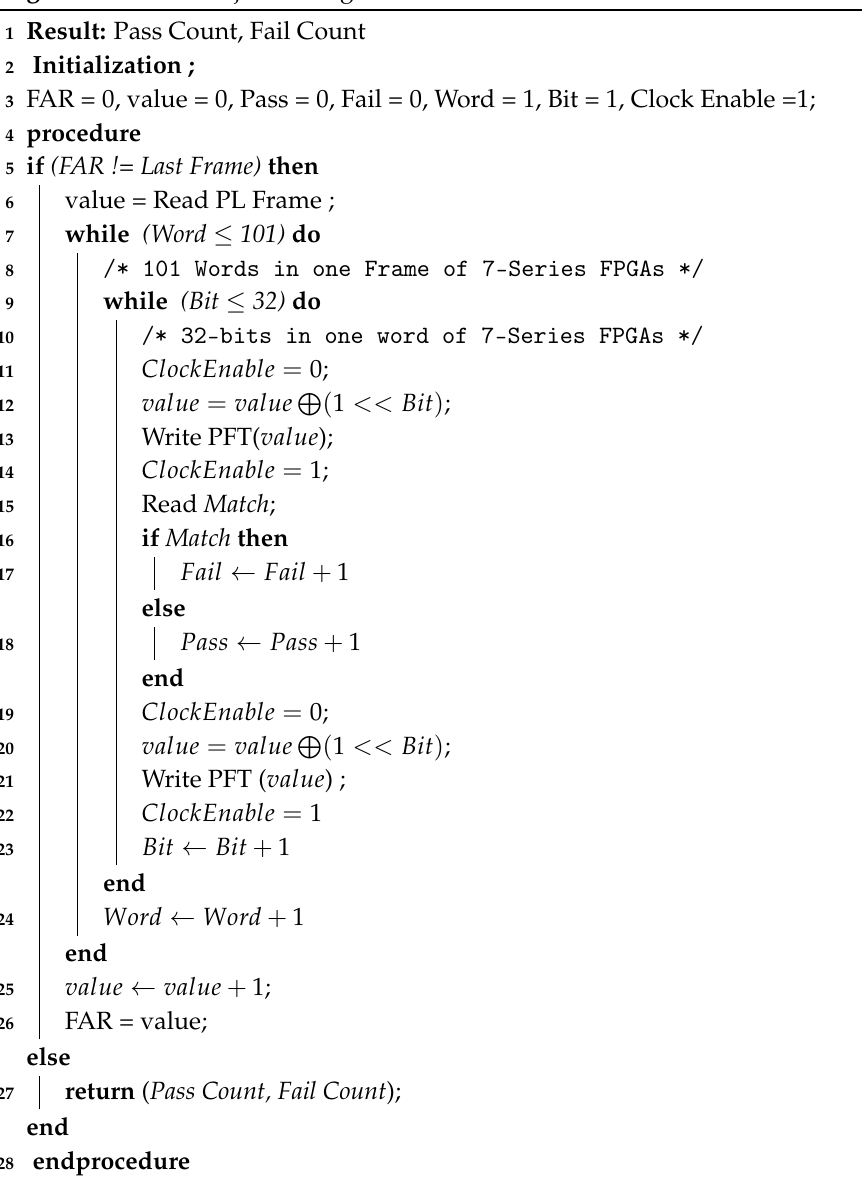
Algorithm 1: Fault Injection